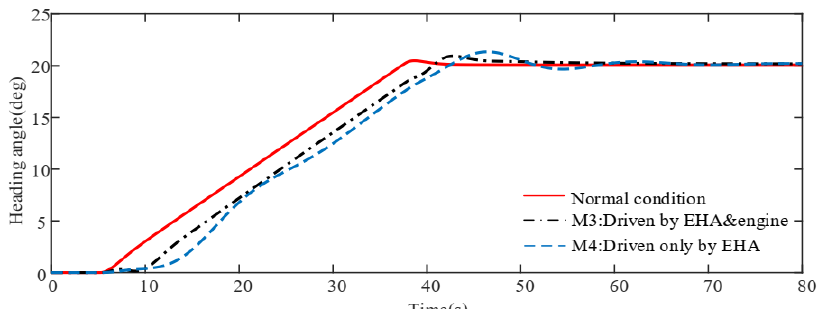
Figure 10. Heading angle response for damage scenario